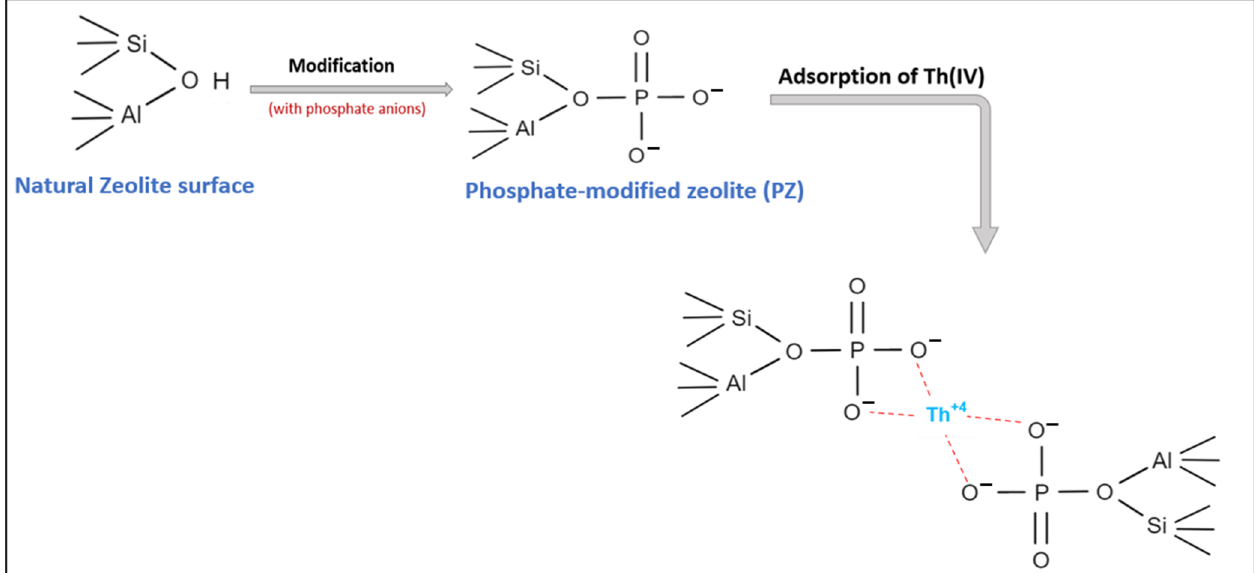
Figure 11. Schematic diagram of phosphate interaction with natural zeolite and the proposed mechanism of thorium adsorption onto phosphate-modified zeolite (PZ).